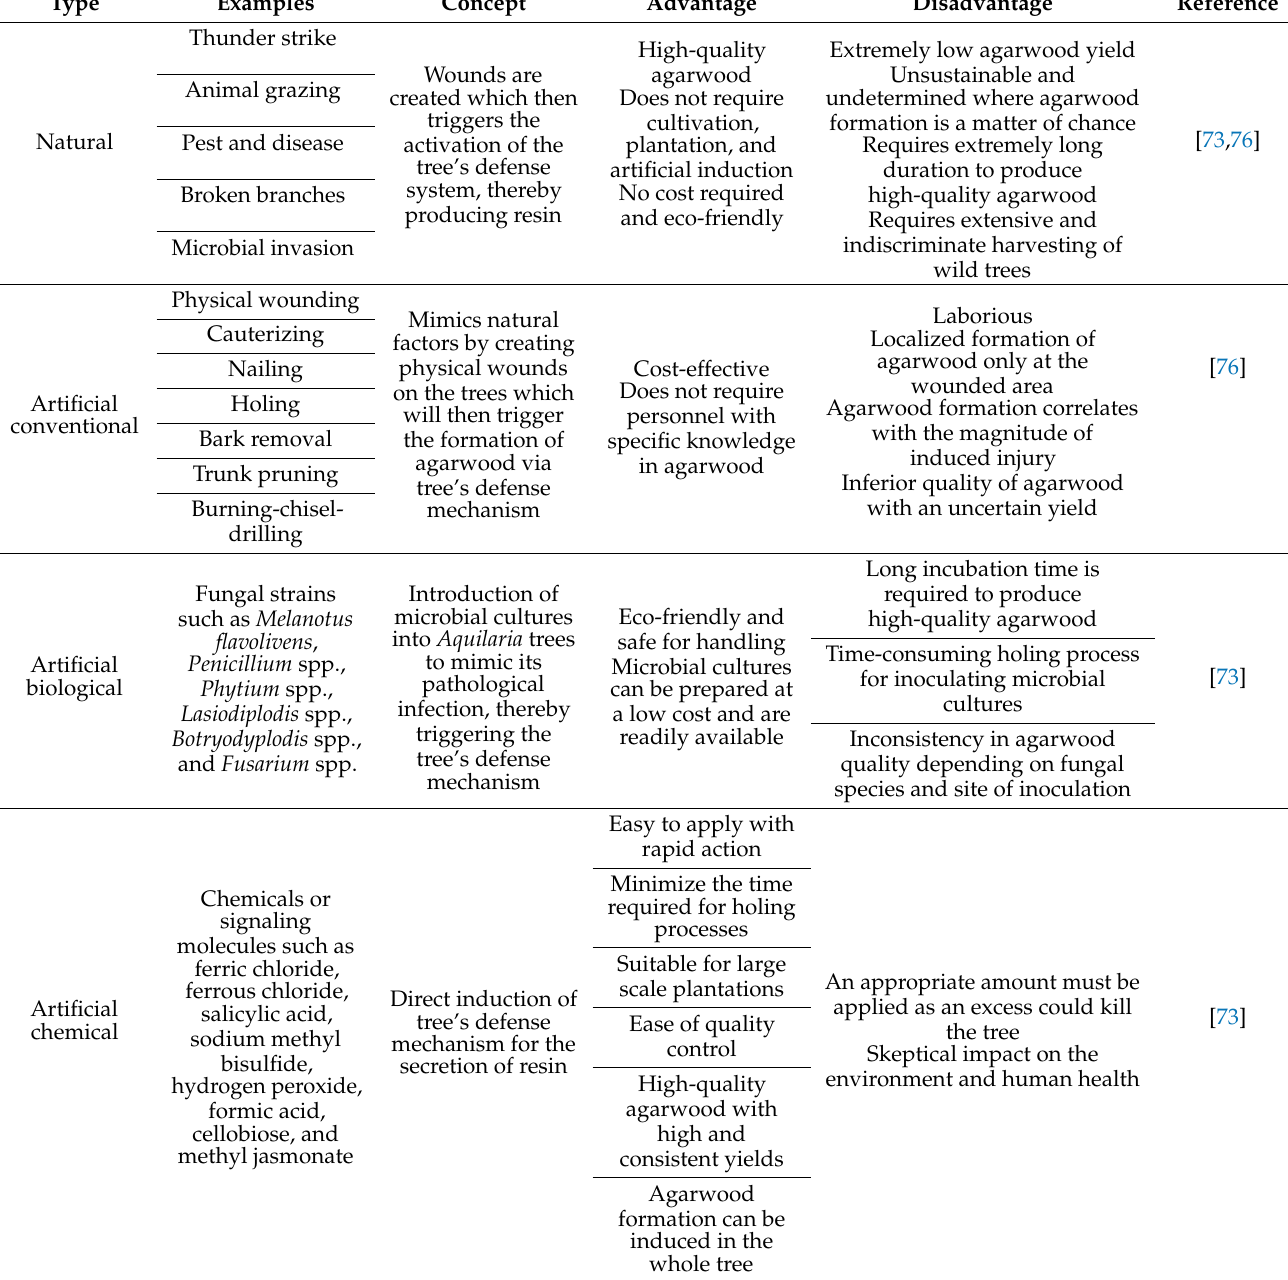
Table 3. Summary of various agarwood-inducing